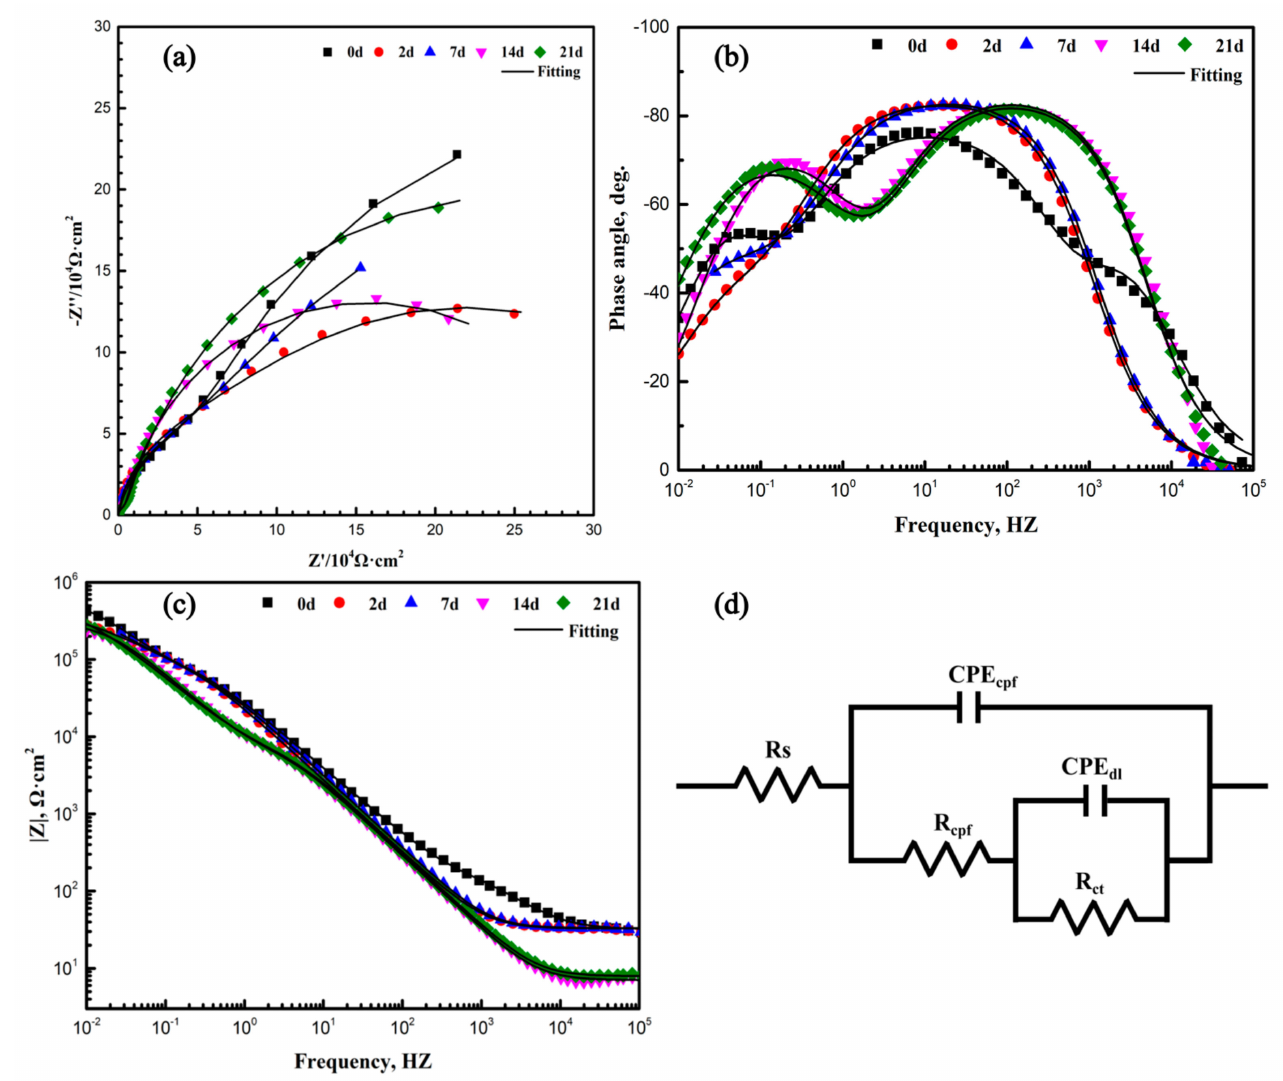
Figure 5. EIS results of MLDHs ( a ) in 3.5 wt.% NaCl solution for various immersion times: Nyquist plots ( a ); Bode plot (phase angle vs. frequency) ( b ); Bode plot (modulus vs. frequency) ( c ); and the used equivalent circuit model for EIS data fitting of MLDHs ( d